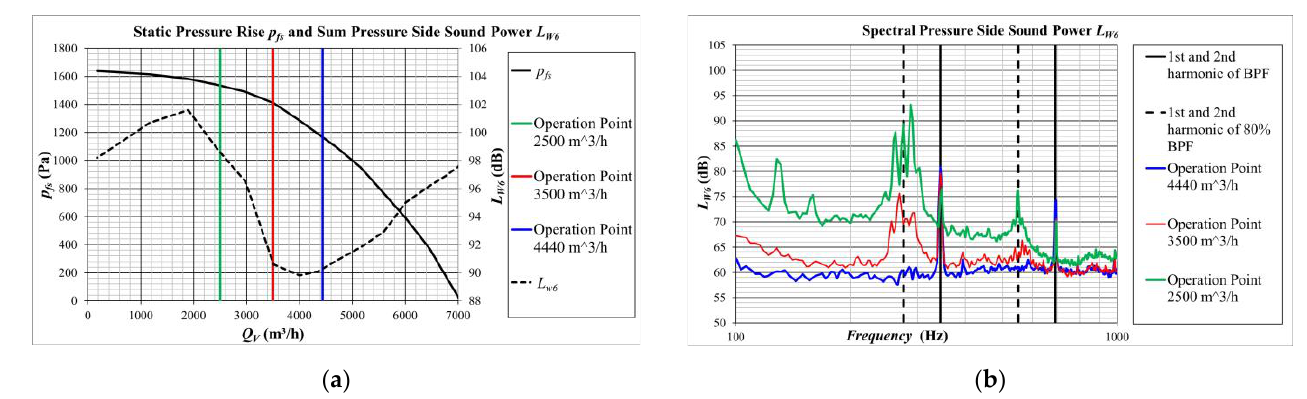
Figure 2. Experimental results: ( a ) characteristic curve for static pressure rise p fs and sum pressure side sound power level L W 6 at rotation speed n = 2975 rpm; ( b ) spectral content of pressure side sound power level L W 6 for three operation points